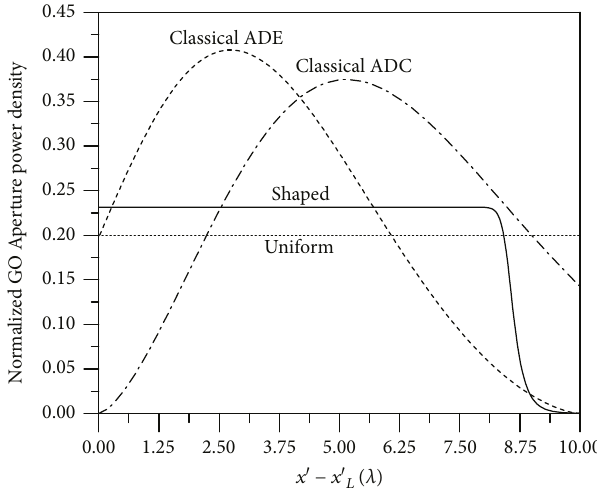
Figure 13: GO aperture power density distributions G ( x ′ ).